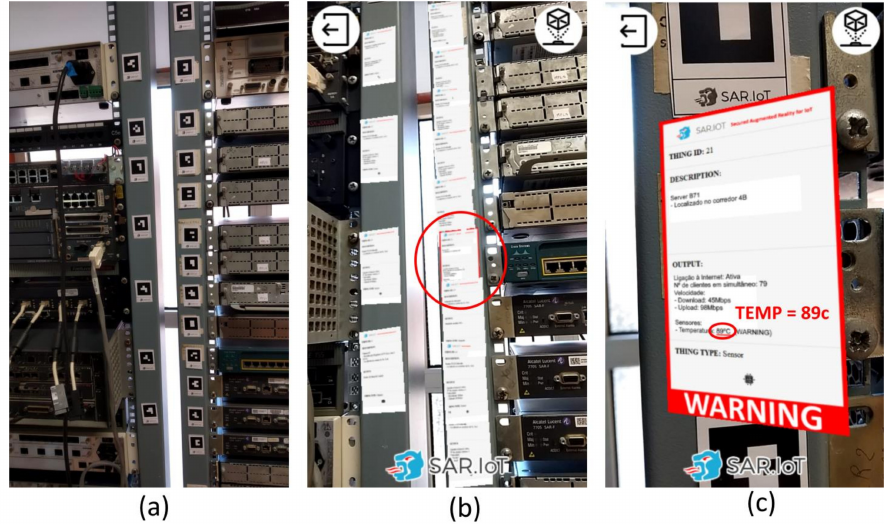
Figure 20. AR markers ( a ) being detected ( b ) and showing an anomaly in a device ( c